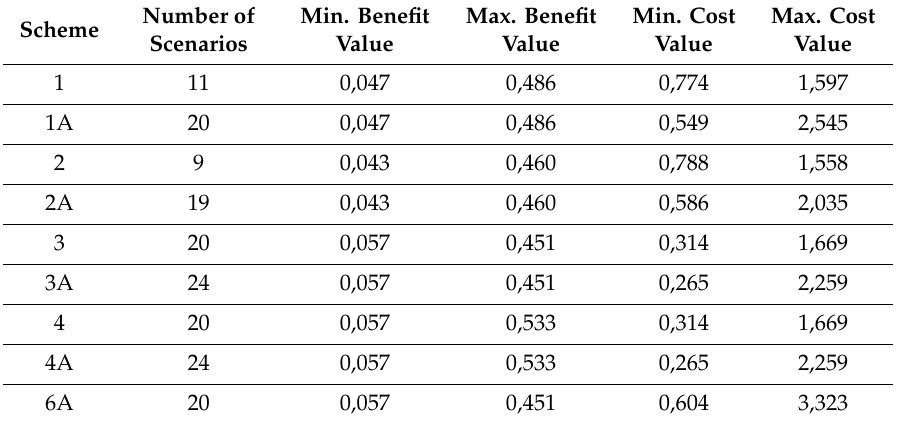
Table 10. Summary of Pareto front and cost and benefit value